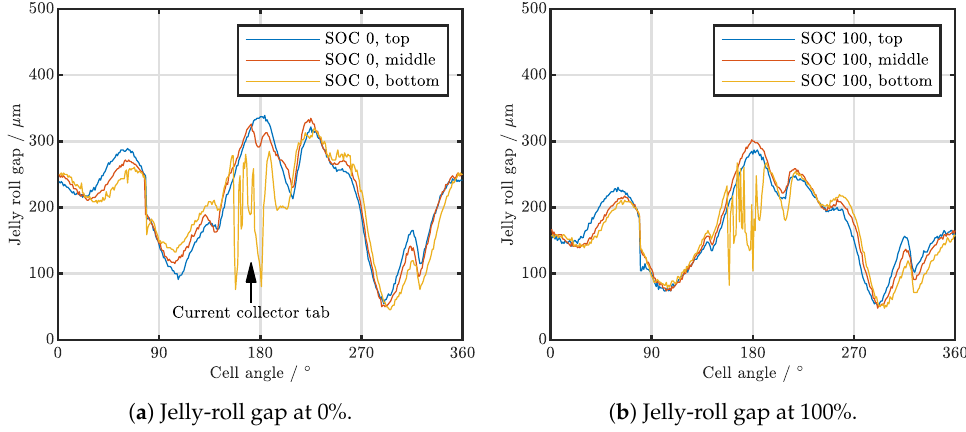
Figure 4. Jelly-roll gaps for a new Samsung INR18650-25RM cell in different cross-sections (Cell 1 in Figure 3). The bottom cross-sections exhibit artifacts at the position of the current collector tab, as the evaluation algorithm was not tuned to detect the tab.